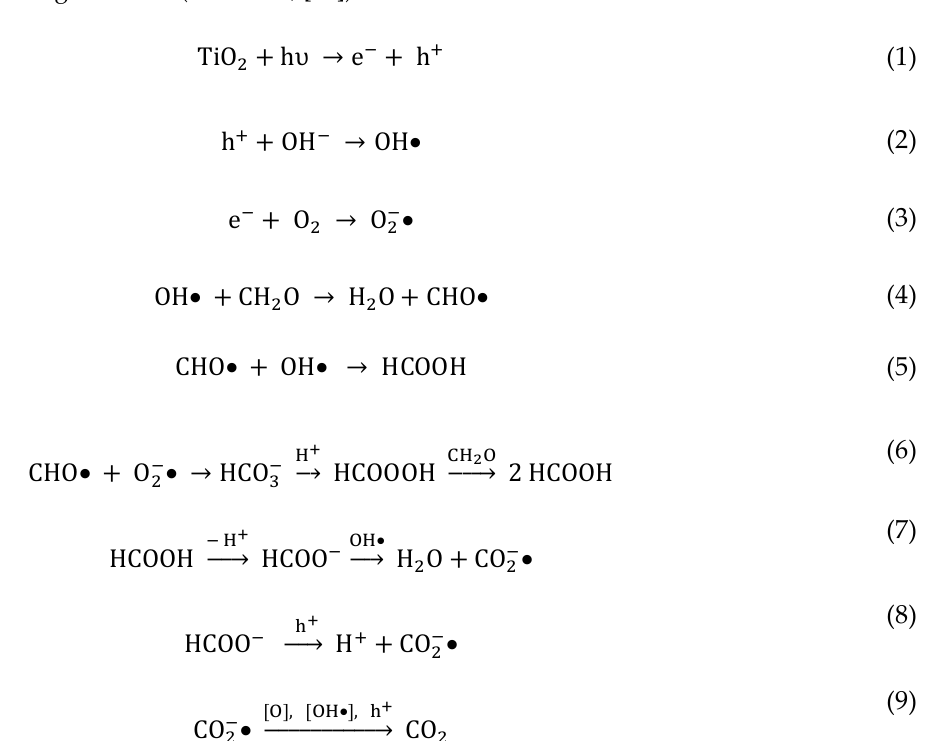
Figure 5. SEM images of ( a ) PAN_Fe and ( b ) PAN_TiO 2 _Fe membranes; ( c ) TEM image of PAN_TiO 2 _Fe membrane.